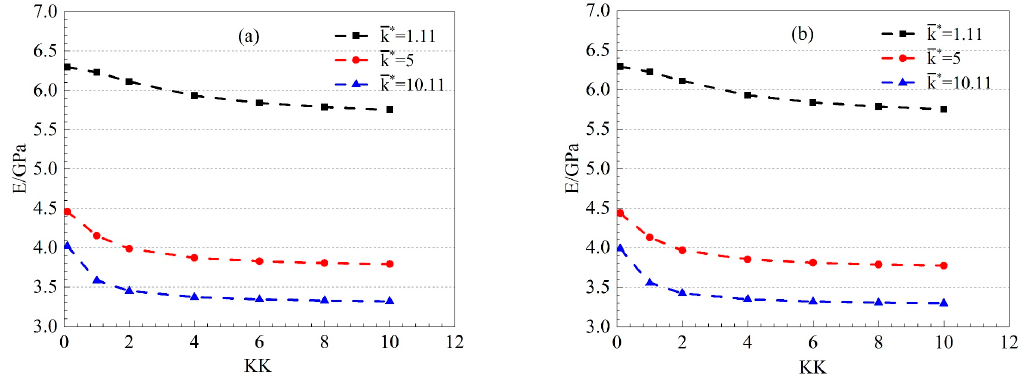
∗ ) and sti ff ness ratio coe ffi cient * k ) and stiffness ratio